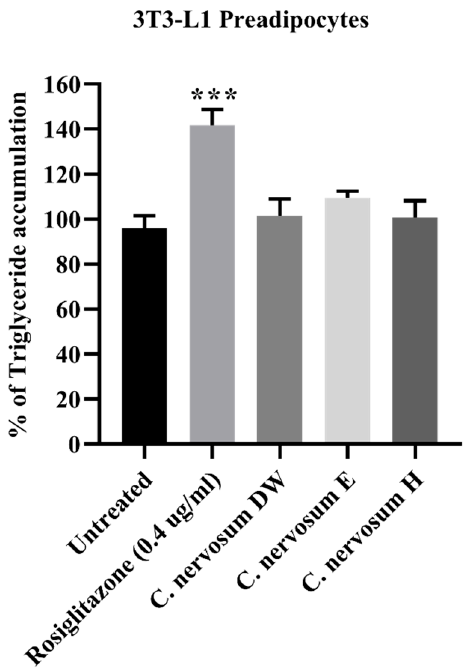
Figure 5. Effect of C. nervosum extracts on lipid accumulation in 3T3-L1 preadipocytes. Data are mean ± SD of four independent experiments. *** p < 0.001 versus the untreated control.